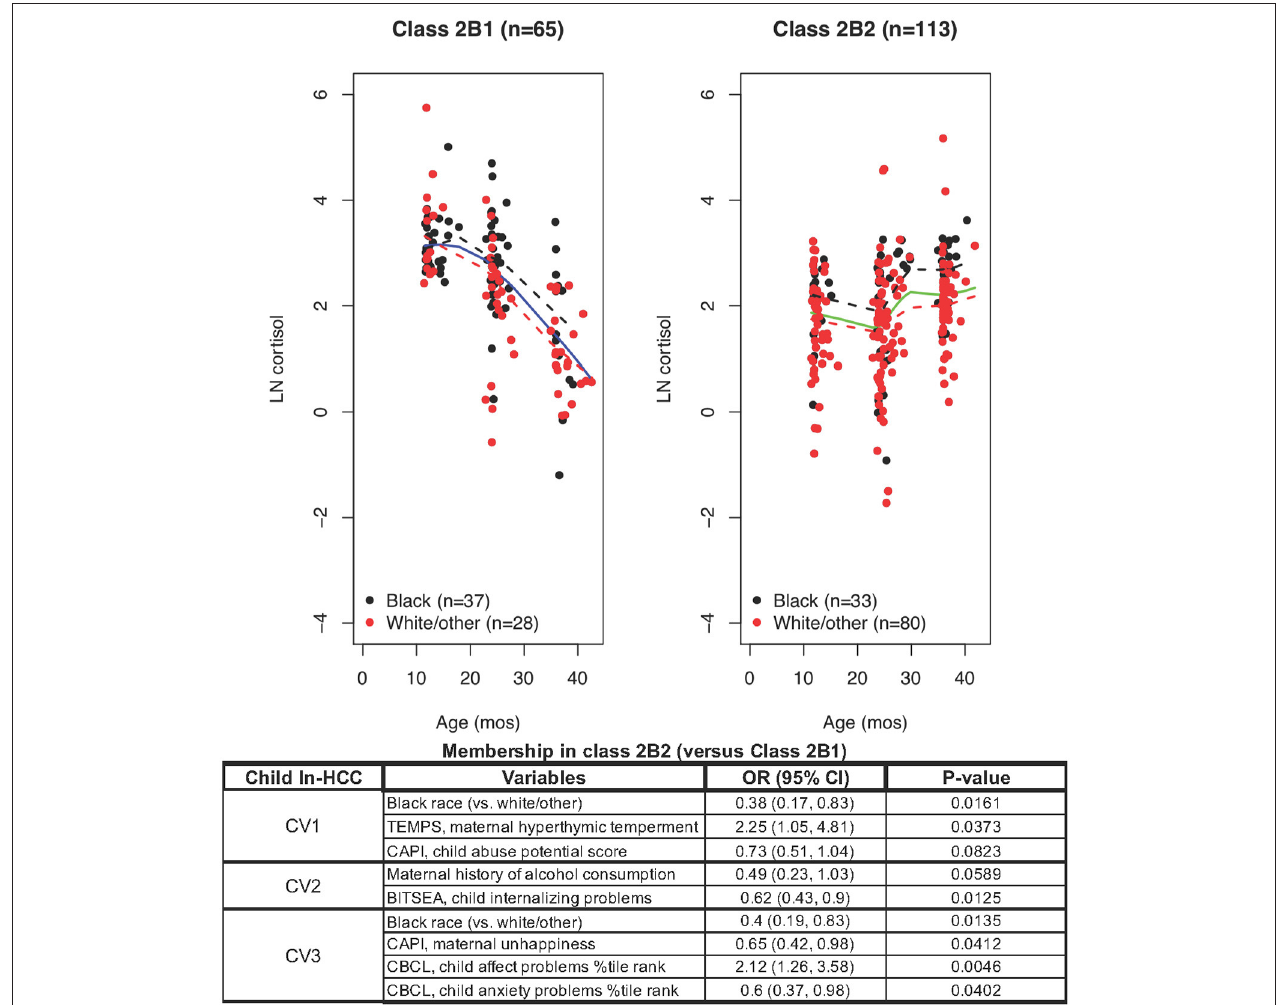
FIGURE 3 | LCMM model exclusively including Class 2B members revealed Class 2B1 and Class 2B2: ln-HCC values plotted by age in months, with solid regression lines for all children, dashed regression lines for Blacks (black) and White/other races (red). Logistic regression revealed that ln-HCC in Class 2B2 was associated with White/other race (CV1, CV3), maternal hyperthymic temperament (CV1) and unhappiness (CV3), the child’s internalizing behaviors (CV2), affect and anxiety problems